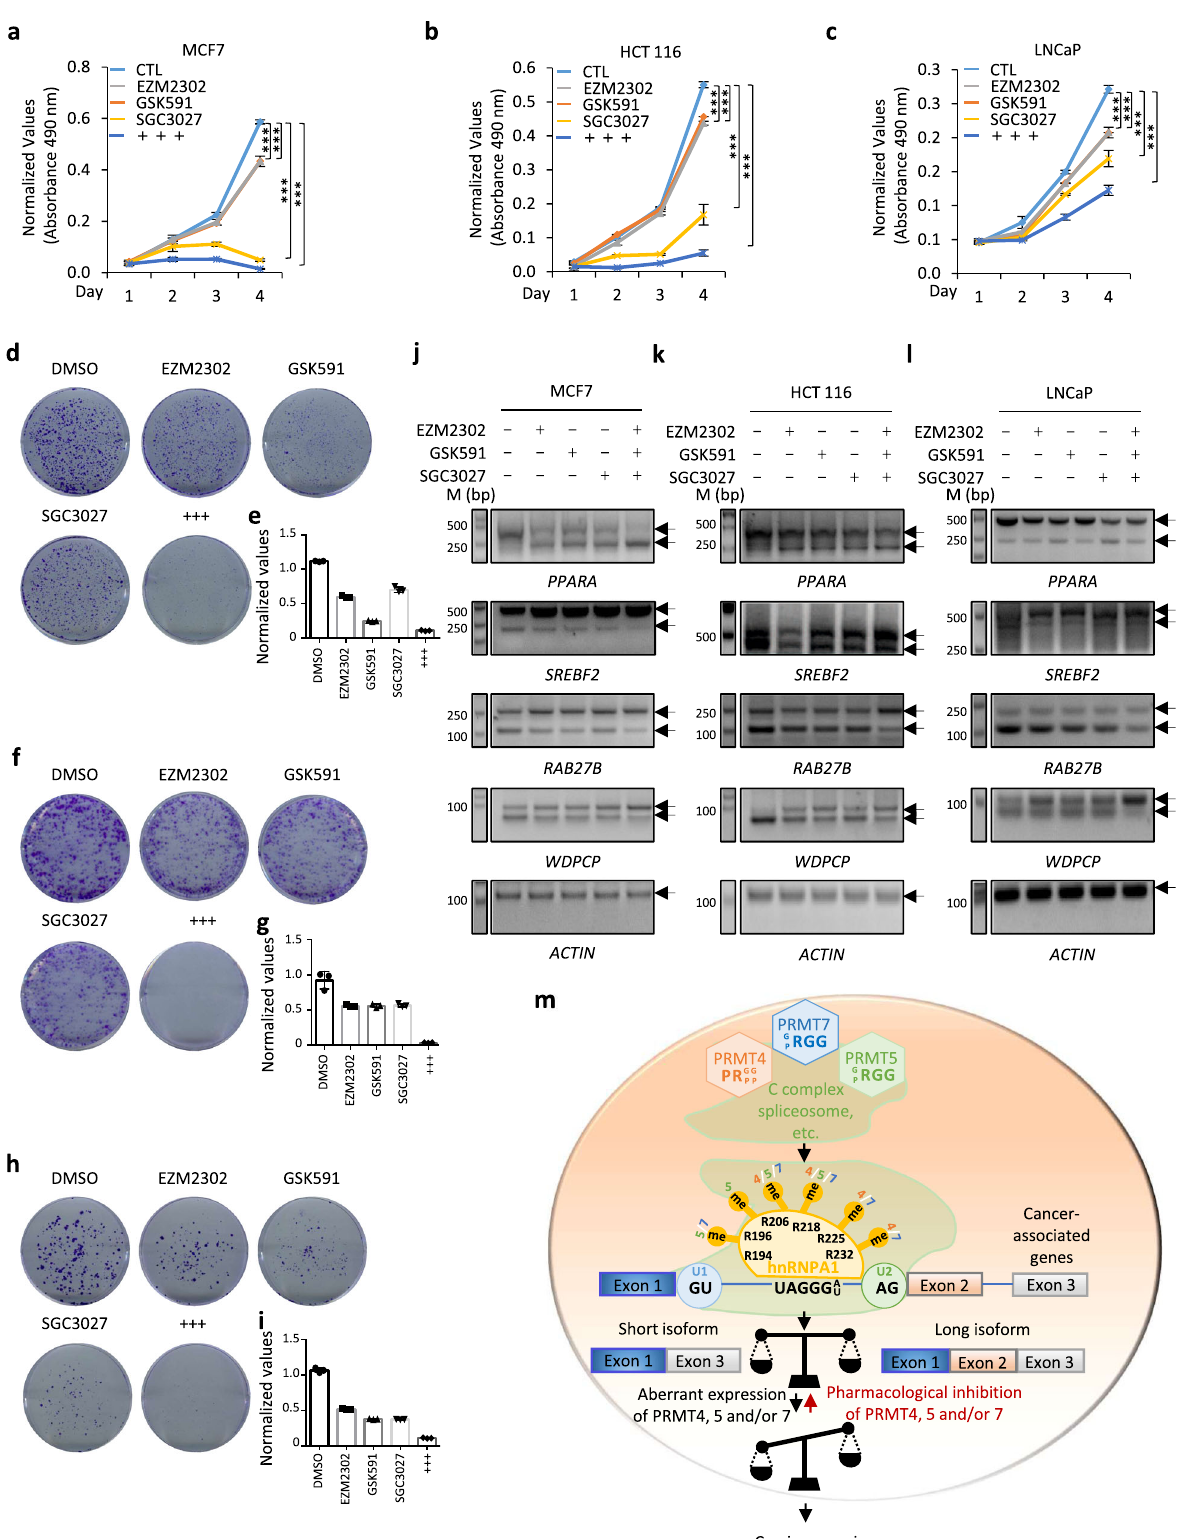
RNA isolation, RT-qPCR, and standard PCR . Total RNA was isolated using Trizol (Invitrogen) following the manufacturer ’ s protocol. First-strand cDNA synthesis from total RNA was carried out using GoScript ™ Reverse Transcription Mix (Promega, random primers), followed by quantitative PCR (qPCR) using AriaMx Real-Time PCR machine (Agilent Technologies). RNA samples were subjected to qPCR to examine gene expression or standard PCR to examine alternative splicing change. Standard error of the mean is depicted. Sequence